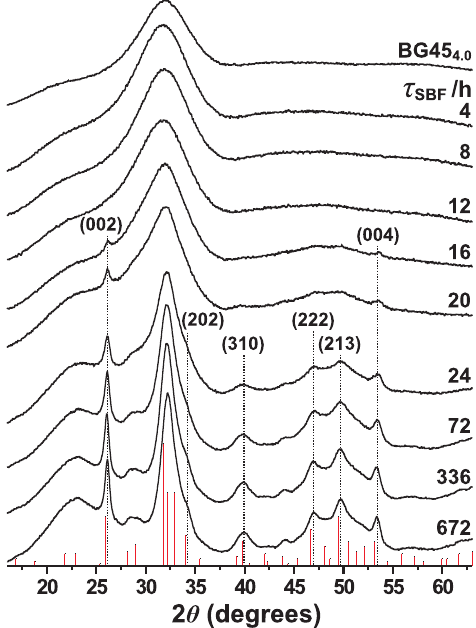
Figure 1. Powder XRD patterns recorded from the pristine BG45 4.0 glass (top trace), as well as the SBF-exposed BG45 4.0 – τ SBF specimens, with the as-indicated SBF-soaking periods ( τ SBF ) increasing from top to bottom. Also shown (red sticks) is a generic diffractogram representative of well-crystalline hydroxyapatite (International Centre for Diffraction Data: data-set 00-09-0432). The dotted vertical lines indicate a selection of Bragg peaks and their associated Miller